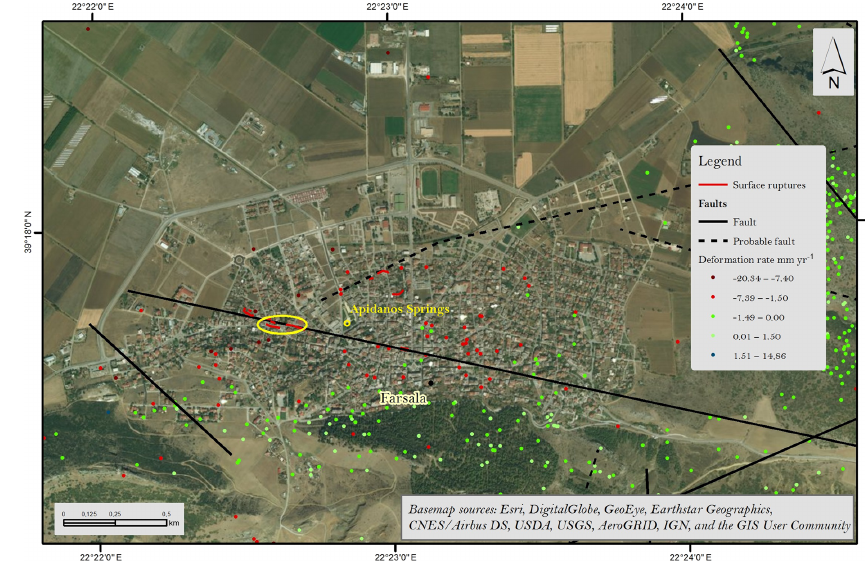
Figure 6. The spatial distribution of the surface raptures and PSI data (modified from Ilia et al., 2018).